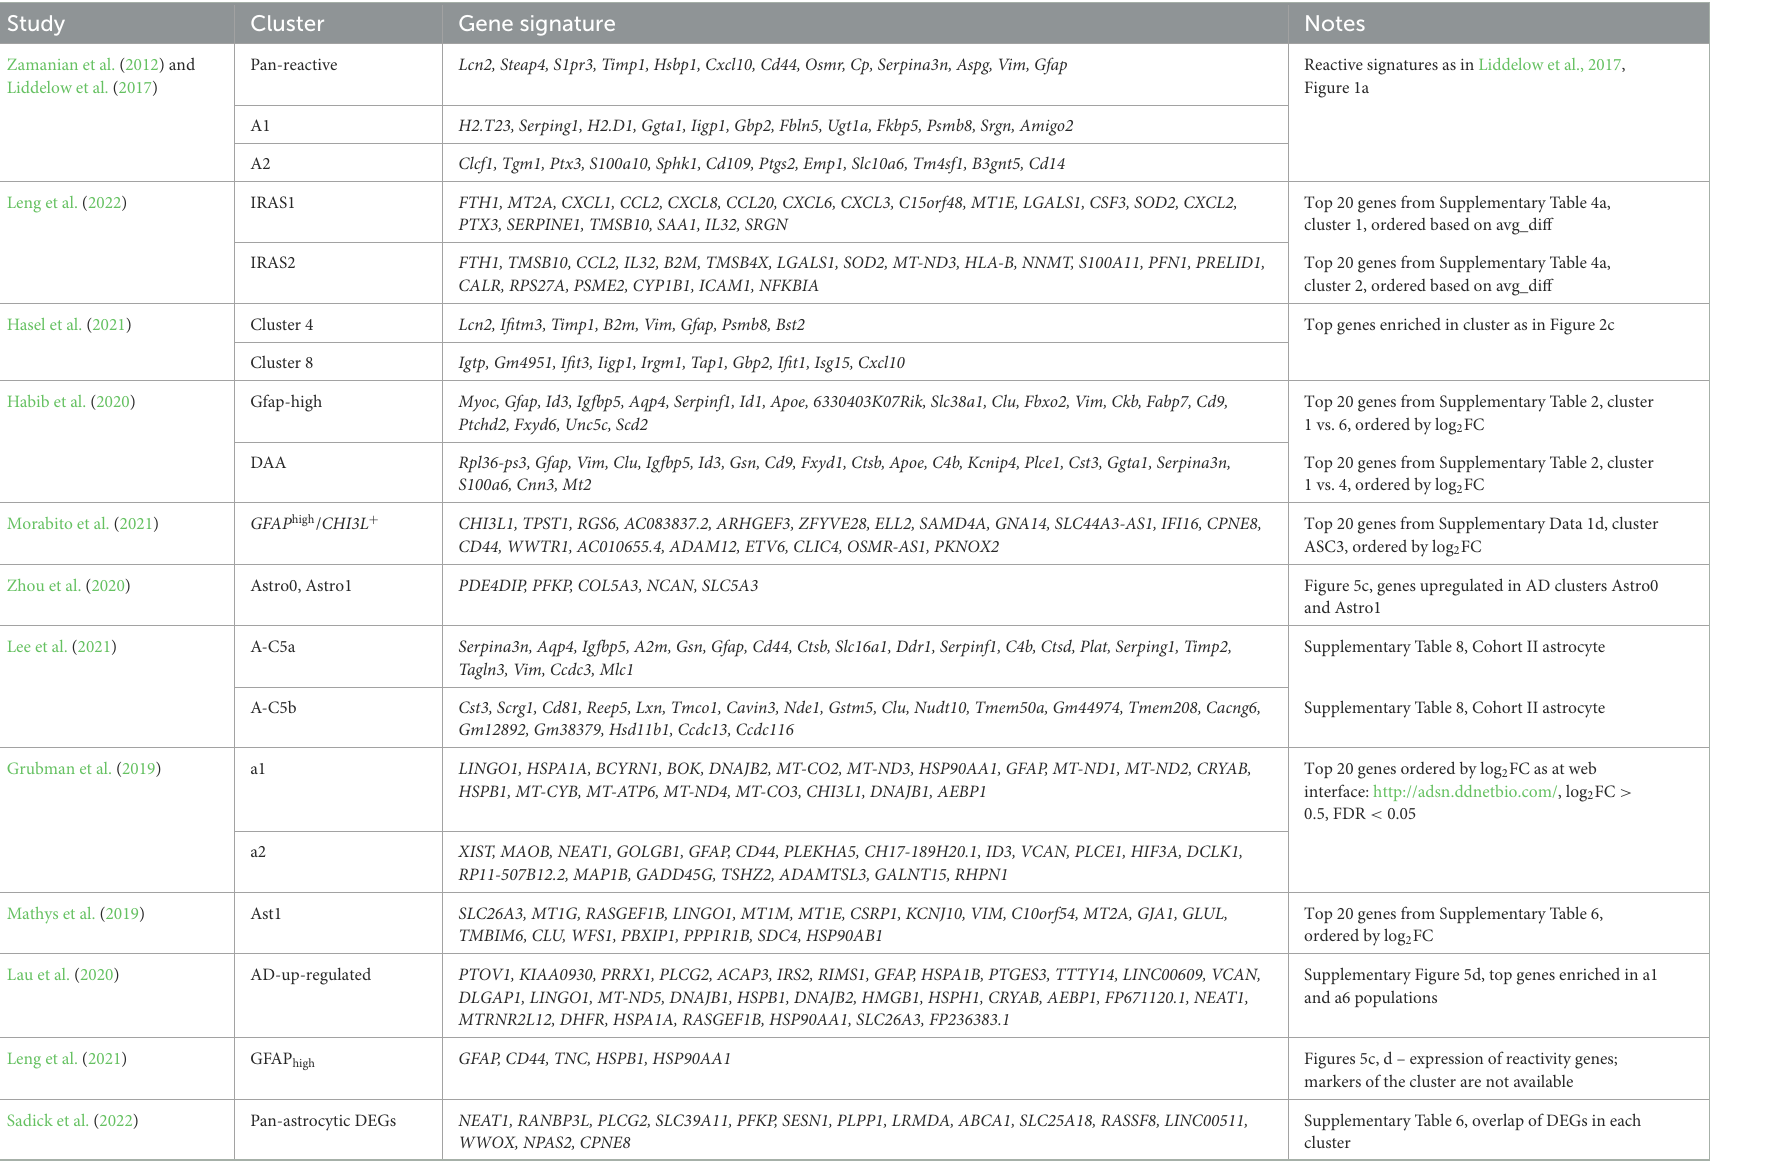
TABLE 1 Gene signatures of selected populations of reactive astrocytes (mostly based on single-cell studies).